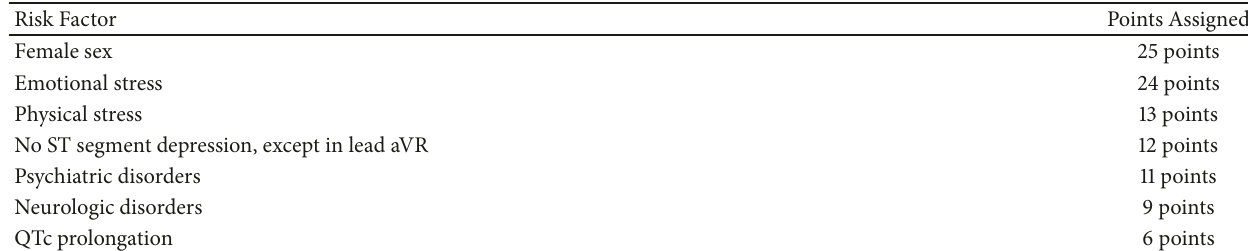
Table 2: InterTAK Diagnostic Score Point System